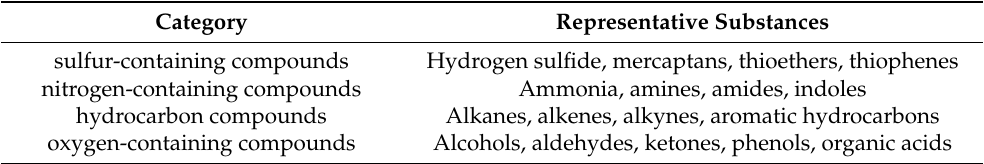
Table 1. Classification of major odorous substances in drainage pipelines.